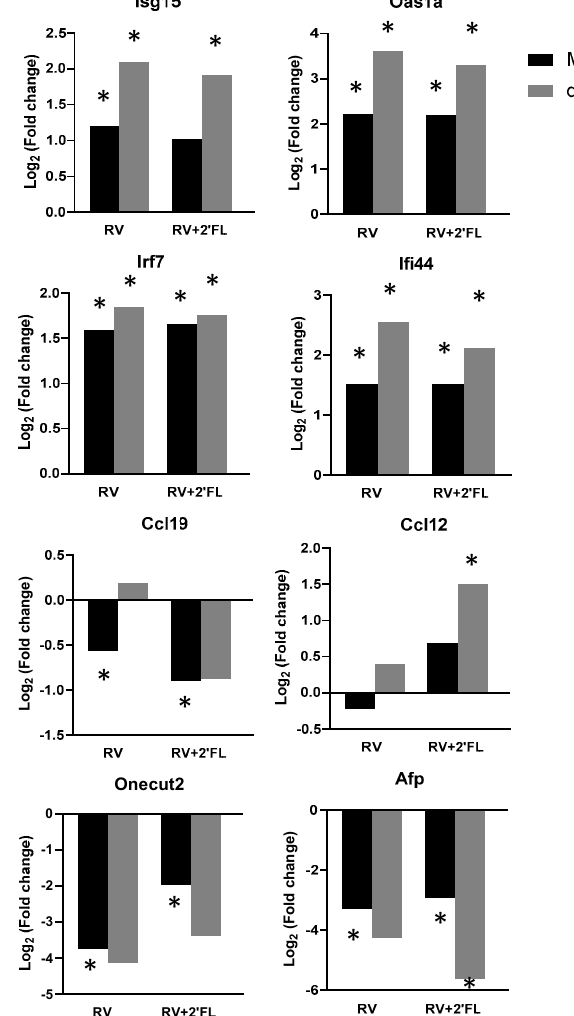
Figure 5. Fold change in selected target genes with respect to REF group by the array results and by Taqman PCR ( n = 4/group in the array and n = 8/group in the qPCR). Statistical differences: * p < 0.05 vs. REF.